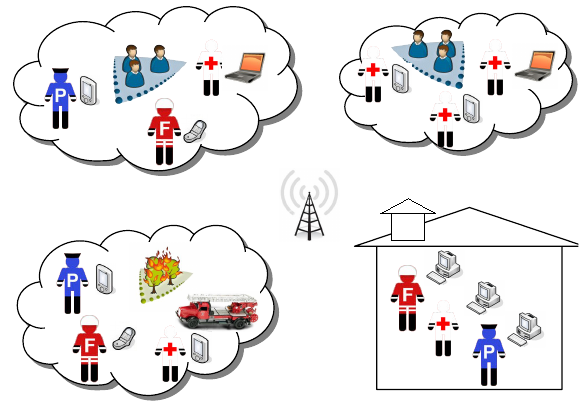
Figure 1. Communication in MCI rescue